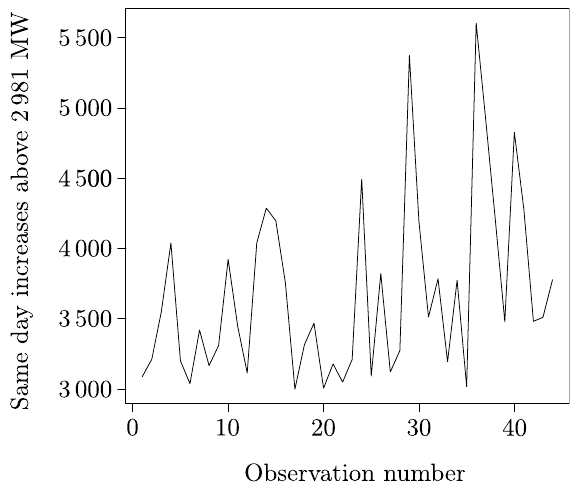
Figure 10: Same day of the week increases above 2